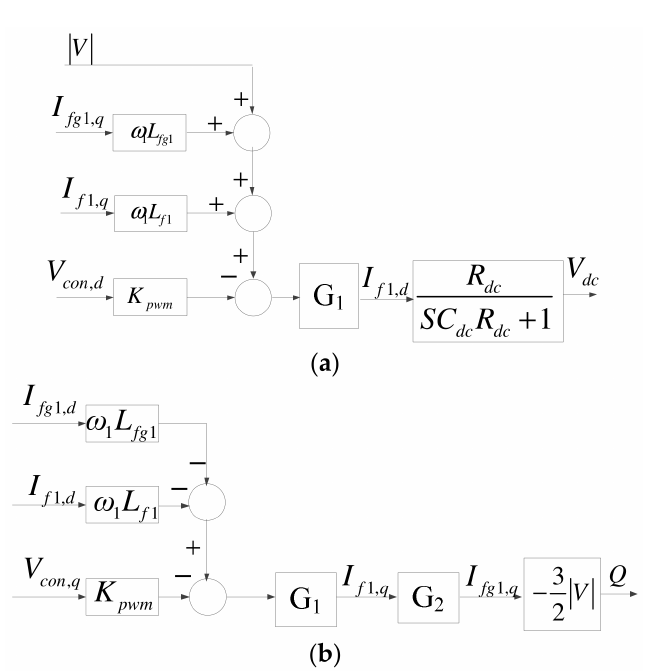
Figure 6. Q-axis mathematical model of the grid inverter: ( a ) d axis; ( b ) q